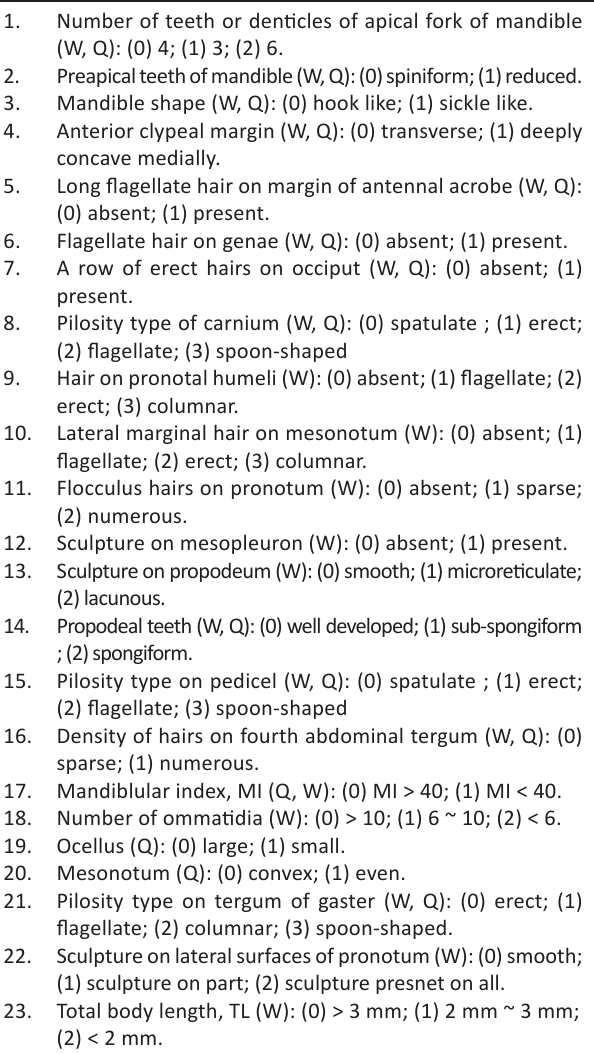
Table 2 Morphological characters and their states used for the phy- logenetic analysis of the genus Strumigenys . (Q: queen, W: worker).